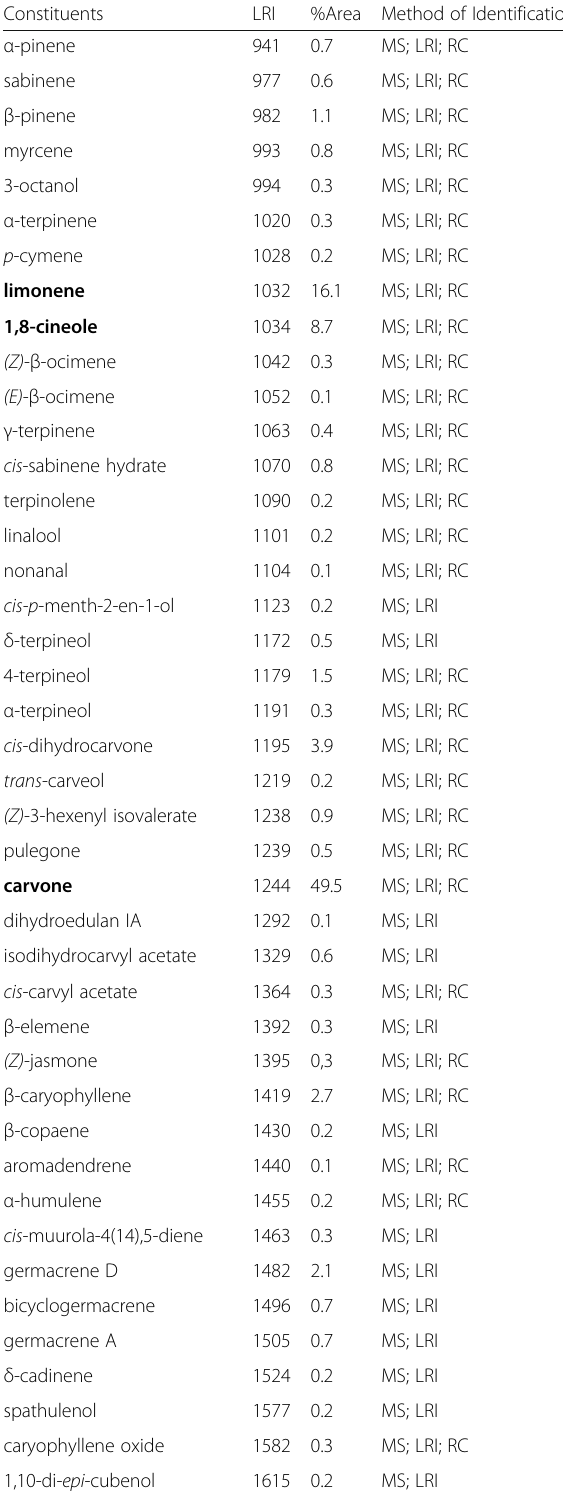
Table 1 Chemical composition of the essential oil from aerial parts of M. spicatai